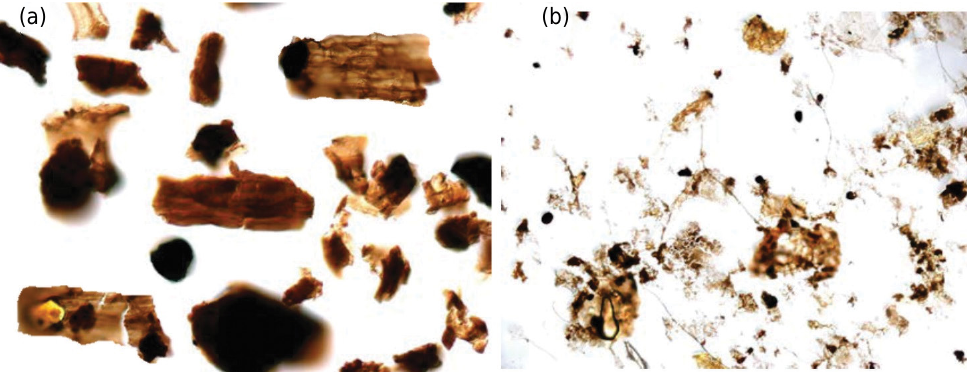
Figure 7. Vegetable cuticles, opaque phytoacetates, gelled phytoaclases present in the organic sub-horizon of the P3 and P6 profiles (a). Structures of amorphous organic matter in the organic sub-horizon (ortstein) of the P6 profile